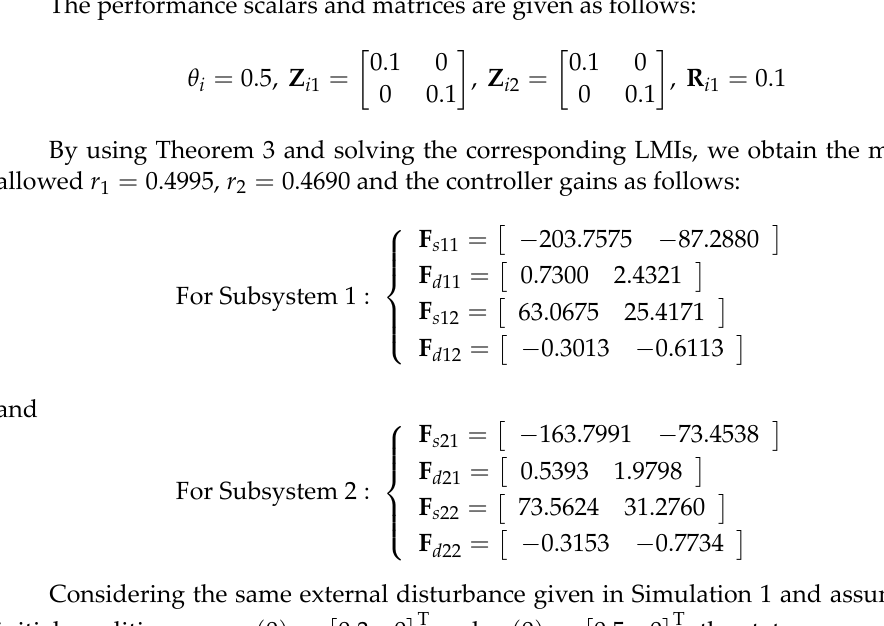
Figure 9. Responses of